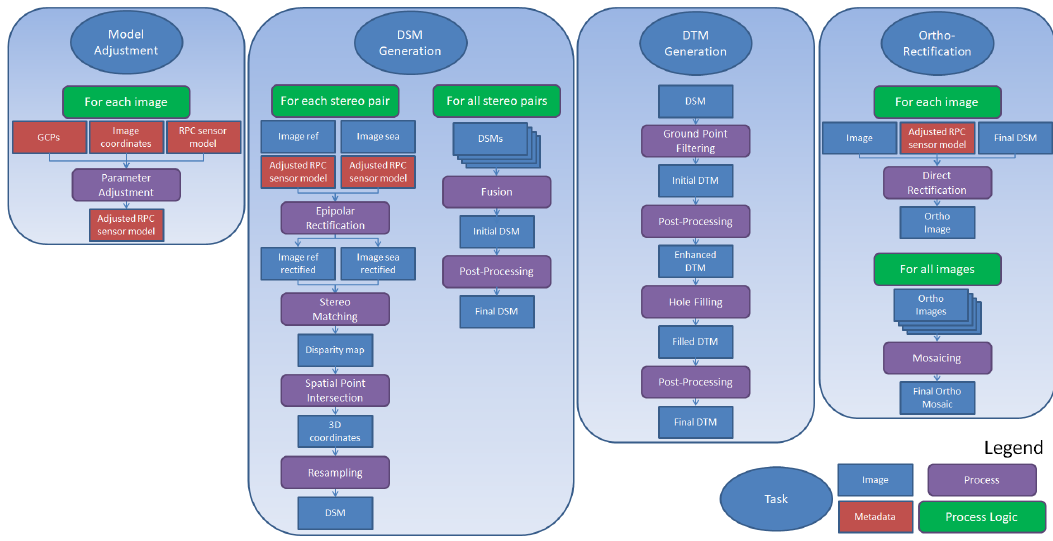
Figure 2. Proposed end-to-end 3D mapping flow graph for multi-view stereo Pléiades images. The